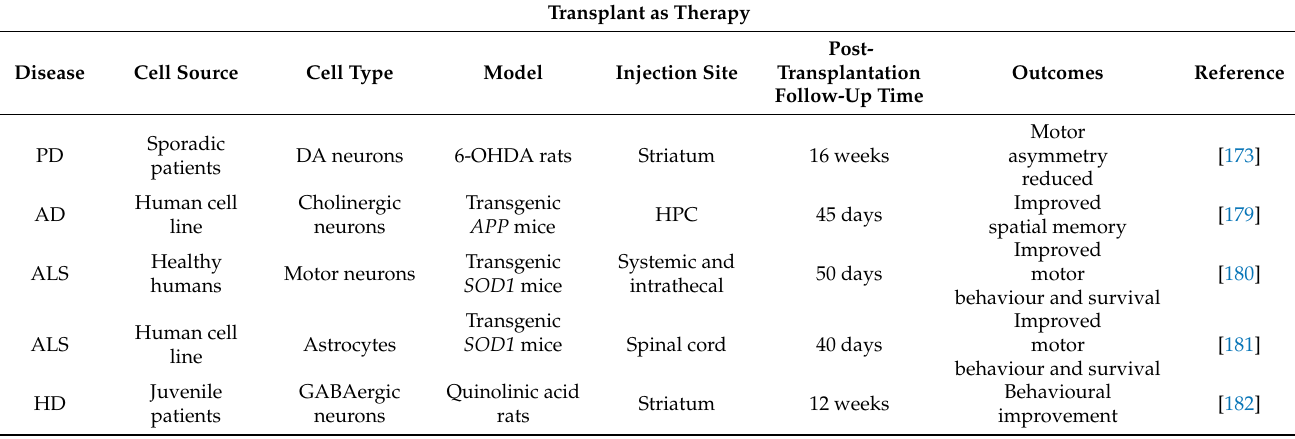
Table 2. Table of preclinical transplant studies performed in rodents using human-derived induced pluripotent stem cells (iPSCs) in neurodegenerative diseases, both as a therapy and to model